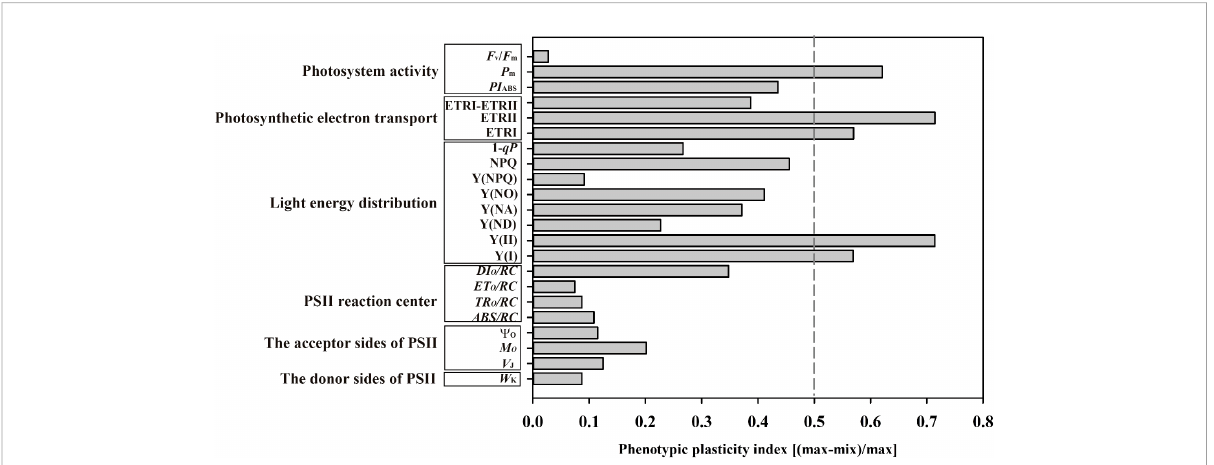
FIGURE 12 Phenotypic plasticity index of the twenty-two chlorophyll fl uorescence variables of photosystem activity, photosynthetic electron transport, light energy distribution, PSII reaction center, the acceptor sides and donor sides of PSII. Means were calculated for seven individuals for each light treatment.